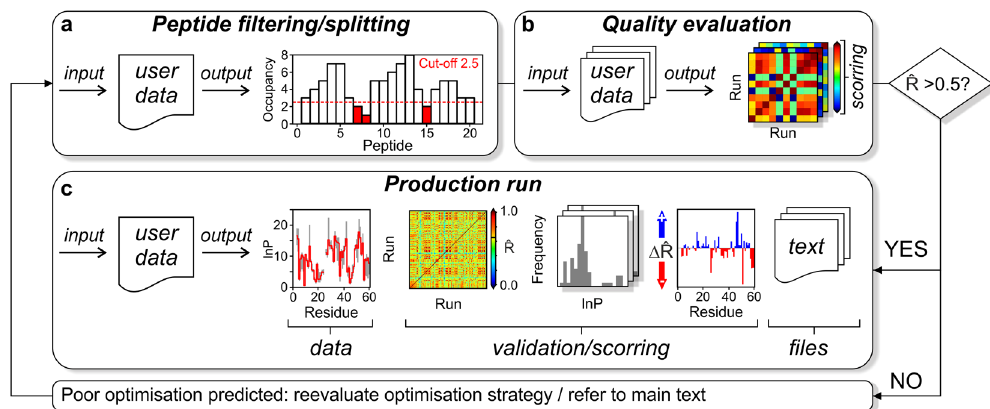
Fig. 4 Recommended work fl ow for HDXmodeller. a Input fi les should be in the form of RFU for each isotopic labelling timepoint and peptide that have been corrected for back and forward exchange. To increase the resolution to which optimisation outputs can be validated it is recommended for whole datasets to be split into different subsections and each subsection submitted as a separate job. Peptide fi ltering should also be performed using the peptide occupancy tool to identify poorly constrained peptides which we recommend eliminating from input fi les. The deletion of weak peptides with poor occupancy scores can also assist in the preparation of data subsections. b A quality evaluation step is recommended involving 10 replicate calculations using default settings. Following the evaluation stage, the R ̂ -matrix value of each output should be inspected for guidance relating to anticipated accuracy at the production phase. Production runs for data that obtain R ̂ -matrix values <0.5 at the evaluation stage is not recommended (refer to main text). c Production runs entail data optimisation using 50 replicates and users should inspect all outputs once the calculations are complete. HDXmodeller prepares several data outputs including various text fi les as well as plots of the lnP of each residue along with the interquartile range. A range of plots for data validation and scoring are also prepared, including the correlation matrix for the whole subsection as well as optimisation histograms and the Δ R ̂ -matrix plot for all